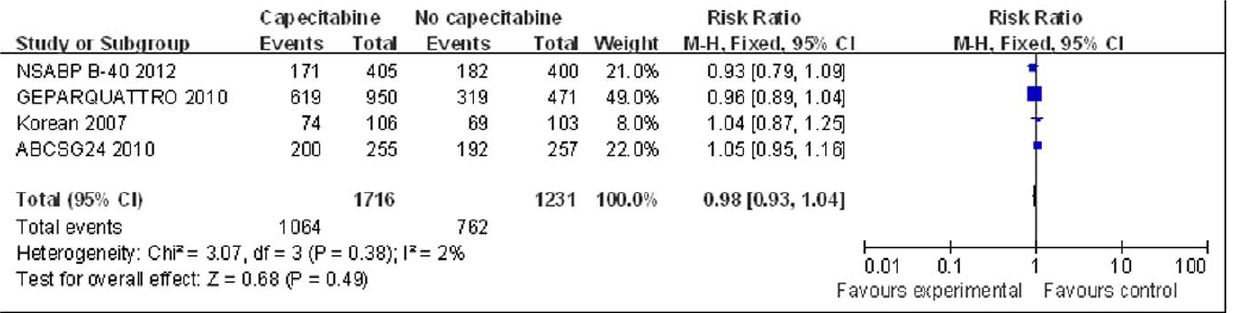
Table S1 Characteristics of studies included in the meta-analysis. Table S2 Summary of drug-related toxicities grade 3 or greater.